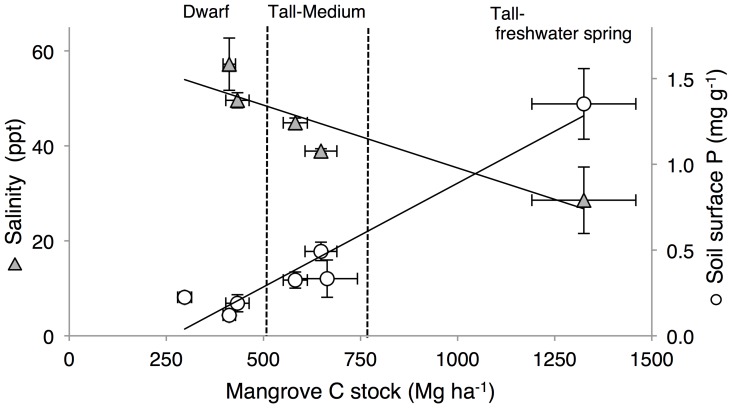
Relationship among mangrove C stocks, interstitial salinity and surface soil phosphorus.Seven mangrove sites were sampled within Sian Ka'an Biosphere Reserve, Mexico; three dwarf, two medium, and two tall mangroves, one of the latter associated to a fresh water spring. Soil phosphorus (P) was measured in the 0–15 cm soil horizon. The correlations are significant with R
2 = 0.54, F = 31.3, p<0.0001 and R
2 = 0.58, F = 26.3, p<0.001 for C stocks against salinity and soil P, respectively. Collectively, salinity and soil P explained 86% of the variance in mangrove C stocks (F = 45.6, p<0.001; VIF = 2.2).